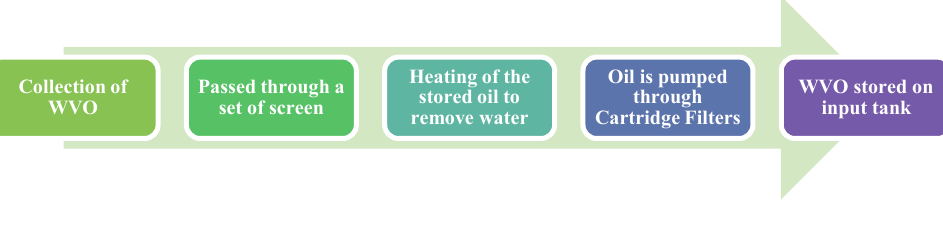
Fig. 4. Process flow diagram of the filtration of waste cooking